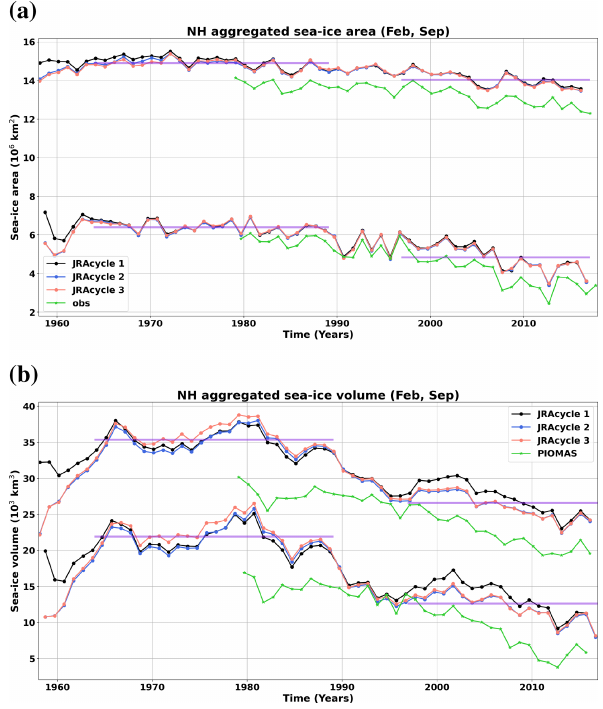
Figure 17. E3SM-Arctic-OSI time series of Northern Hemisphere aggregated (a) sea-ice area and (b) sea-ice volume for the months of February and September. Results from the three JRA cycles are plotted as black, blue, and pink lines, using actual years instead of model years (similarly to Fig. 16a). Green lines represent SSM/I observations in the upper panel and PIOMAS results in the lower panel. The two purple lines indicate the distinct averaged values of sea-ice area and volume for the first part of the cycles (years 1964– 1988) and the second part of the cycles (years 1997–2016). Note that these two regimes correspond to the two periods used to com- pute separate climatologies in the vertical profiles of Figs.